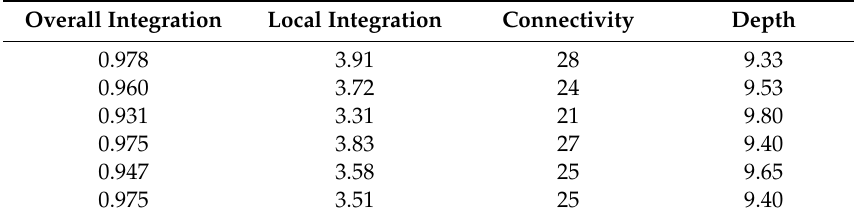
Table 4. Comparison of space syntax indexes in urban structure.